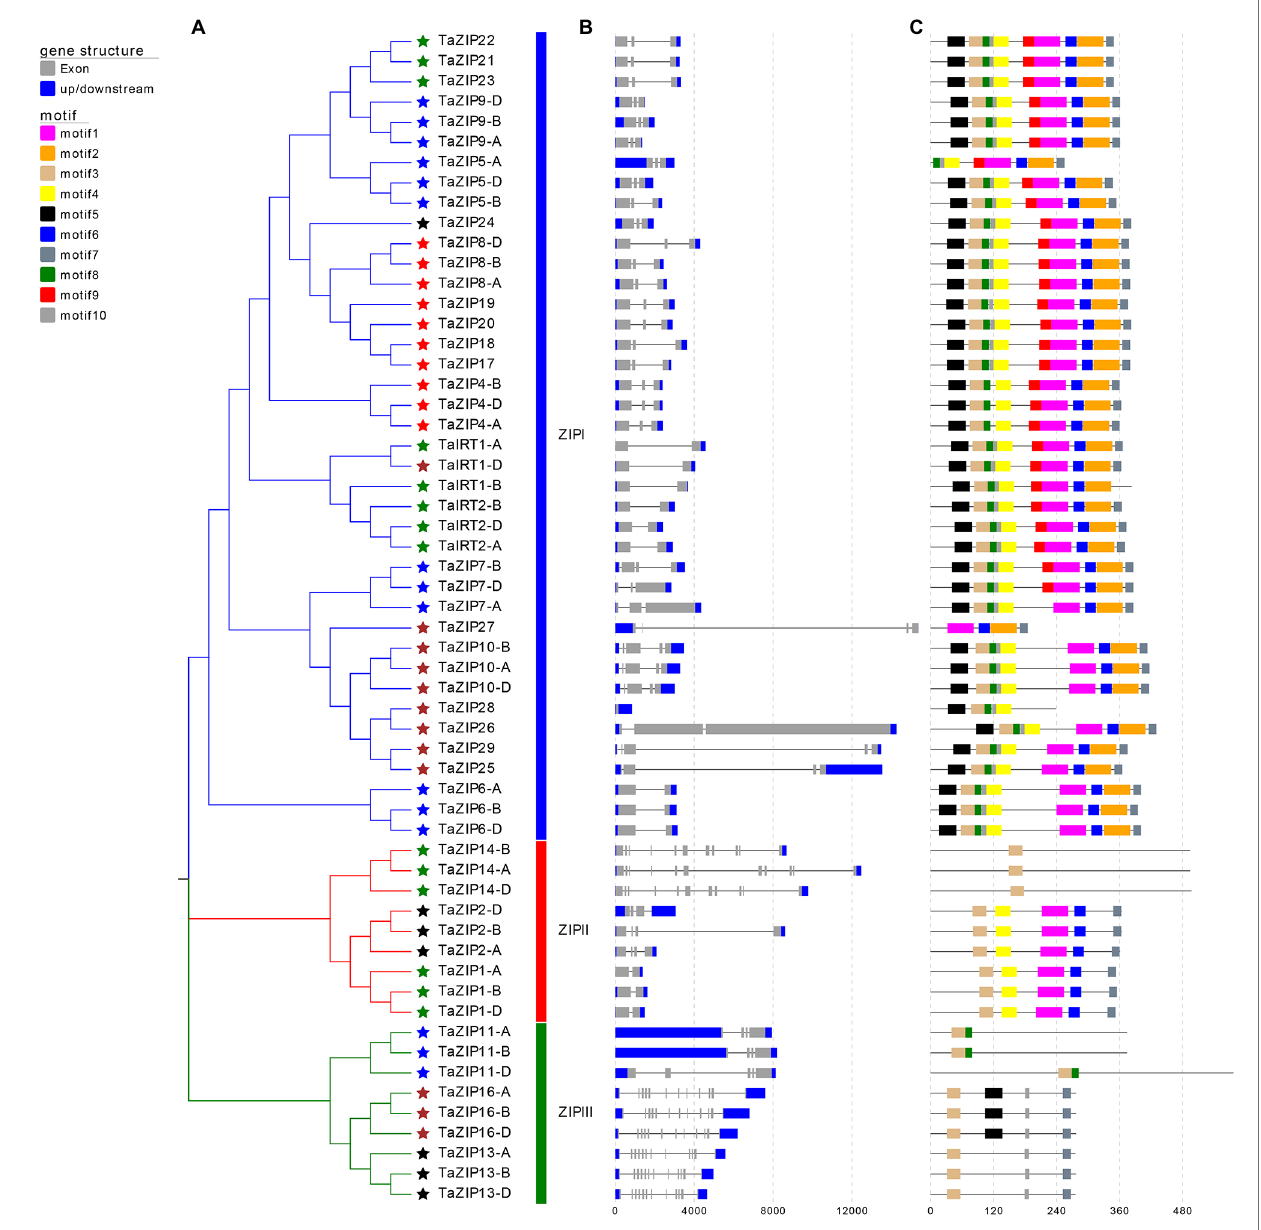
FIGURE 2 | Gene structures and conserved motifs of these identified 58 TaZIP proteins. (A) Phylogenetic relationship of these 58 TaZIP genes; (B) exon-intron structures of these TaZIP genes. Blue boxes represent UTRs, gray boxes represent exons, and gray lines represent introns; (C) conserved protein motifs of these TaZIP proteins. The boxes in different colors represent different motifs, and the gray lines represent non-conserved